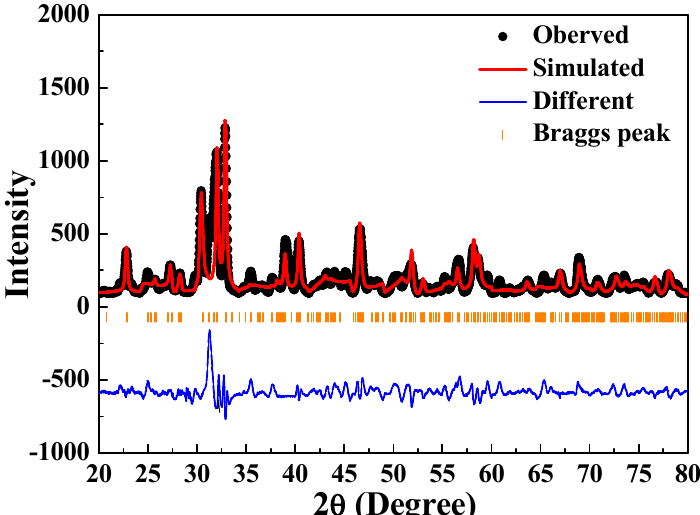
Figure 10. Results of the Rietveld refinement performed for the [Sr 0.99 Eu 0.01 ] 3 MgSi 2 O 8 phosphor sintered at 1400 °C.